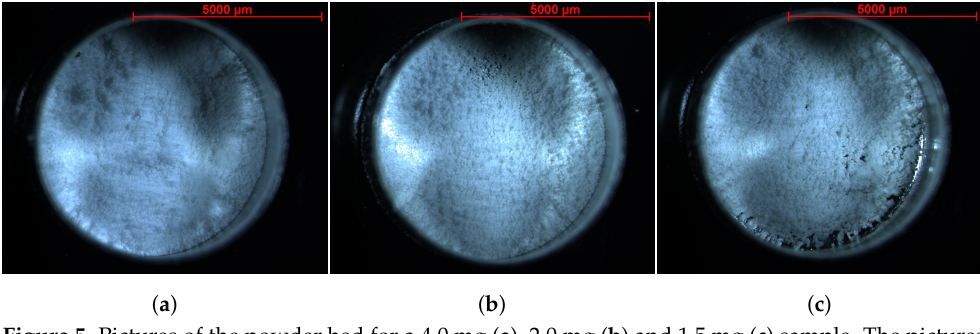
Figure 5. Pictures of the powder bed for a 4.0 mg ( a ), 2.0 mg ( b ) and 1.5 mg ( c ) sample. The pictures were taken with a zoom factor of 19.2 using a Zeiss SteREO Discovery V20 microscope. The dark areas on top are caused by a non-uniform light